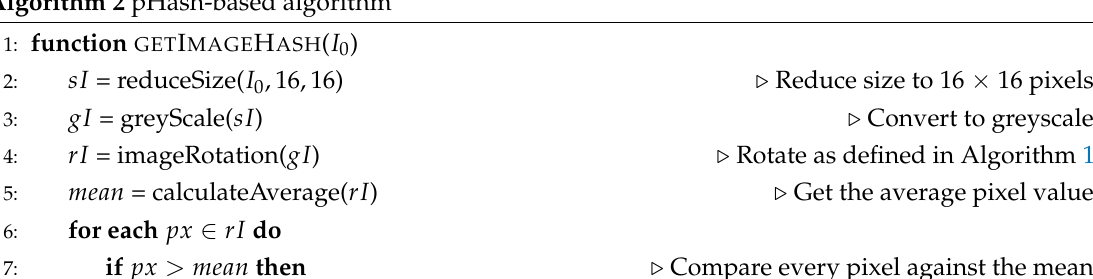
Algorithm 2 pHash-based